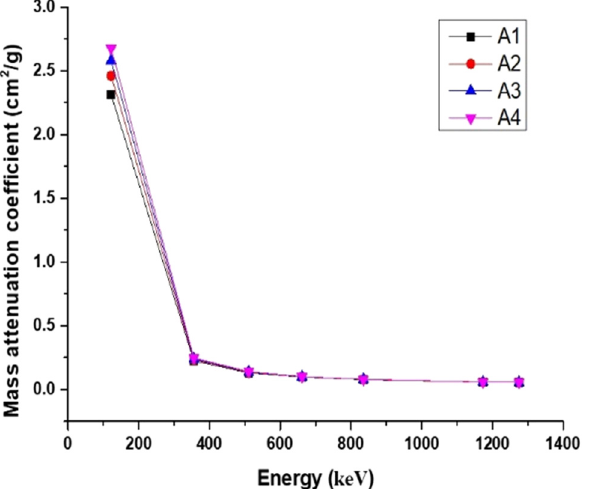
Figure 3: MAC of the glasses using EPICS2017.